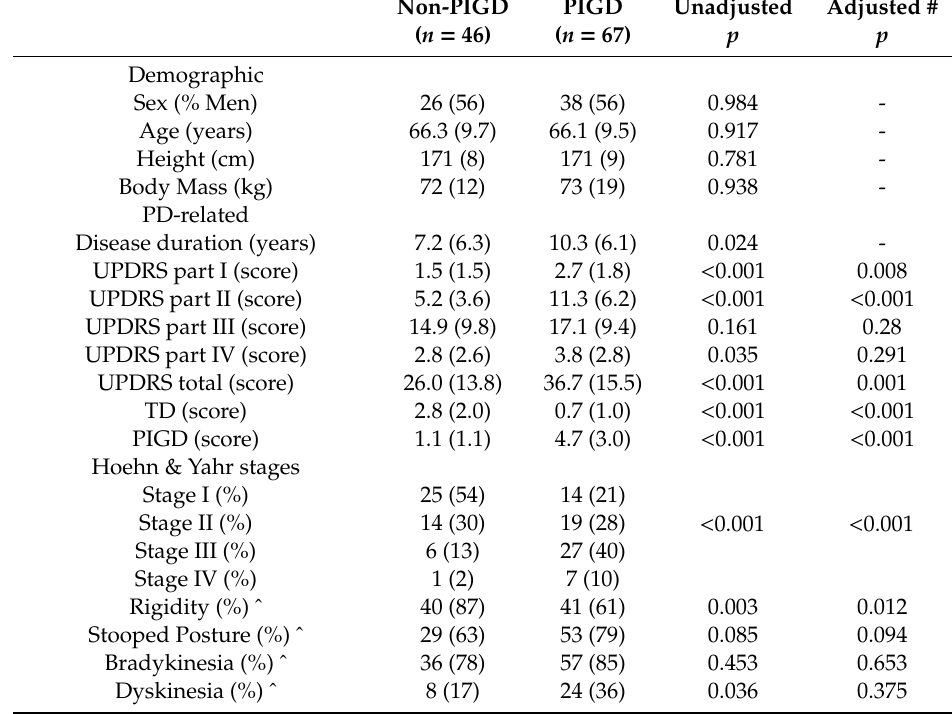
Table 1. Parkinson’s disease and health-related characteristics for the non-postural instability and gait di ffi culty (PIGD) and PIGD groups. Data are presented as mean (SD) unless stated otherwise. Non-PIGD PIGD